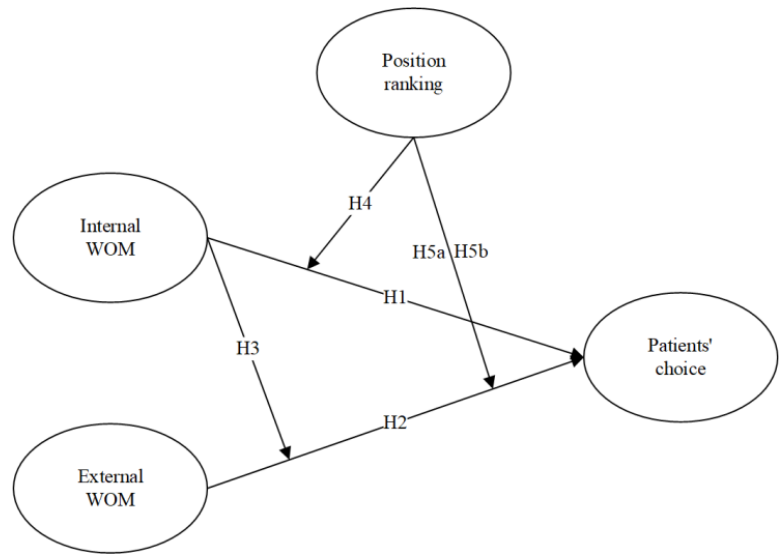
Figure 1. Research model of this study.